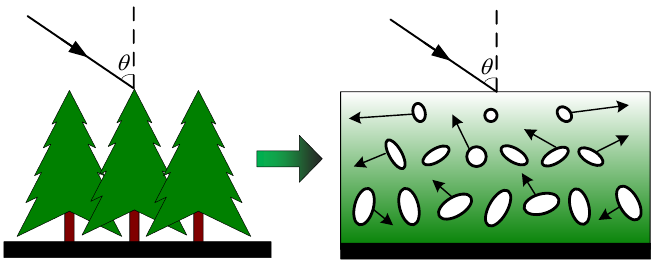
Figure 3. Schematic of the proposed physical model.